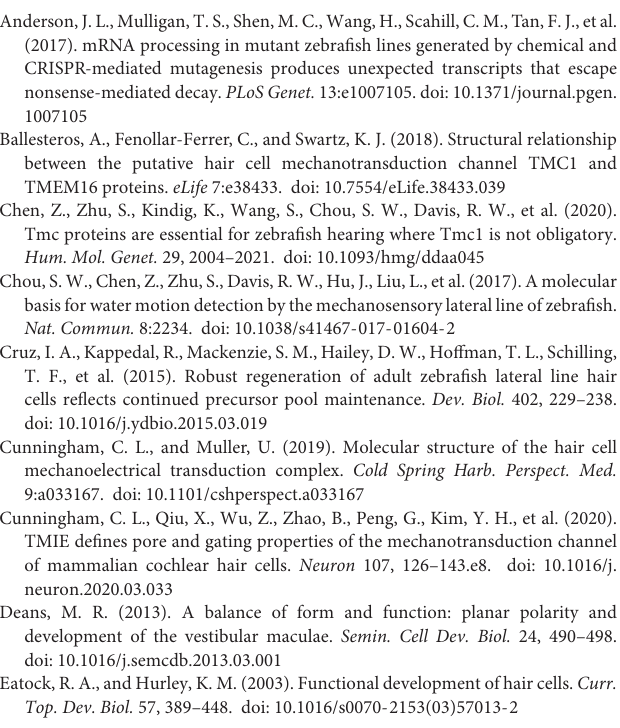
Supplementary Figure 1 | Symmetric and asymmetric models of Tmc dependencies within the